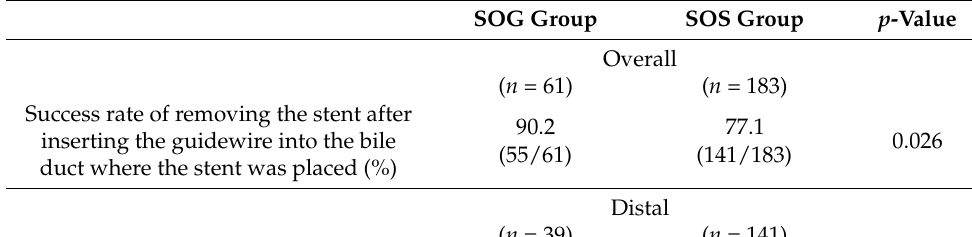
SOG Group SOS Group p -Value Overall ( n = 61) ( n = 183) 90.2 77.1 0.026 (55/61) (141/183) Distal ( n = 39) ( n = 141) 92.3